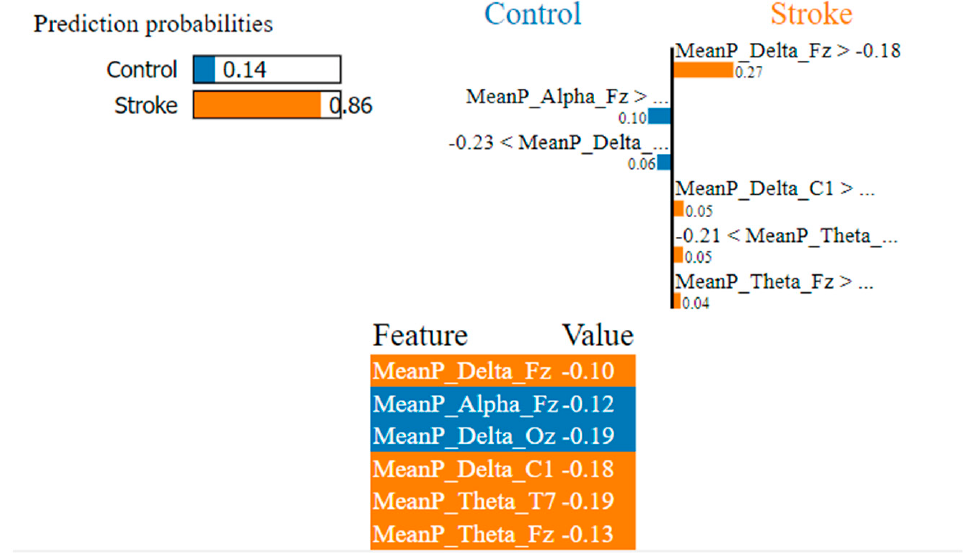
Figure 6. Visualization of the local contribution of EEG features through the LIME model in classifying a single test instance (predicted class = Stroke) using the Adaptive Gradient Boosting model. The orange-marked cells represent the features that contributed most to classifying the Stroke class.